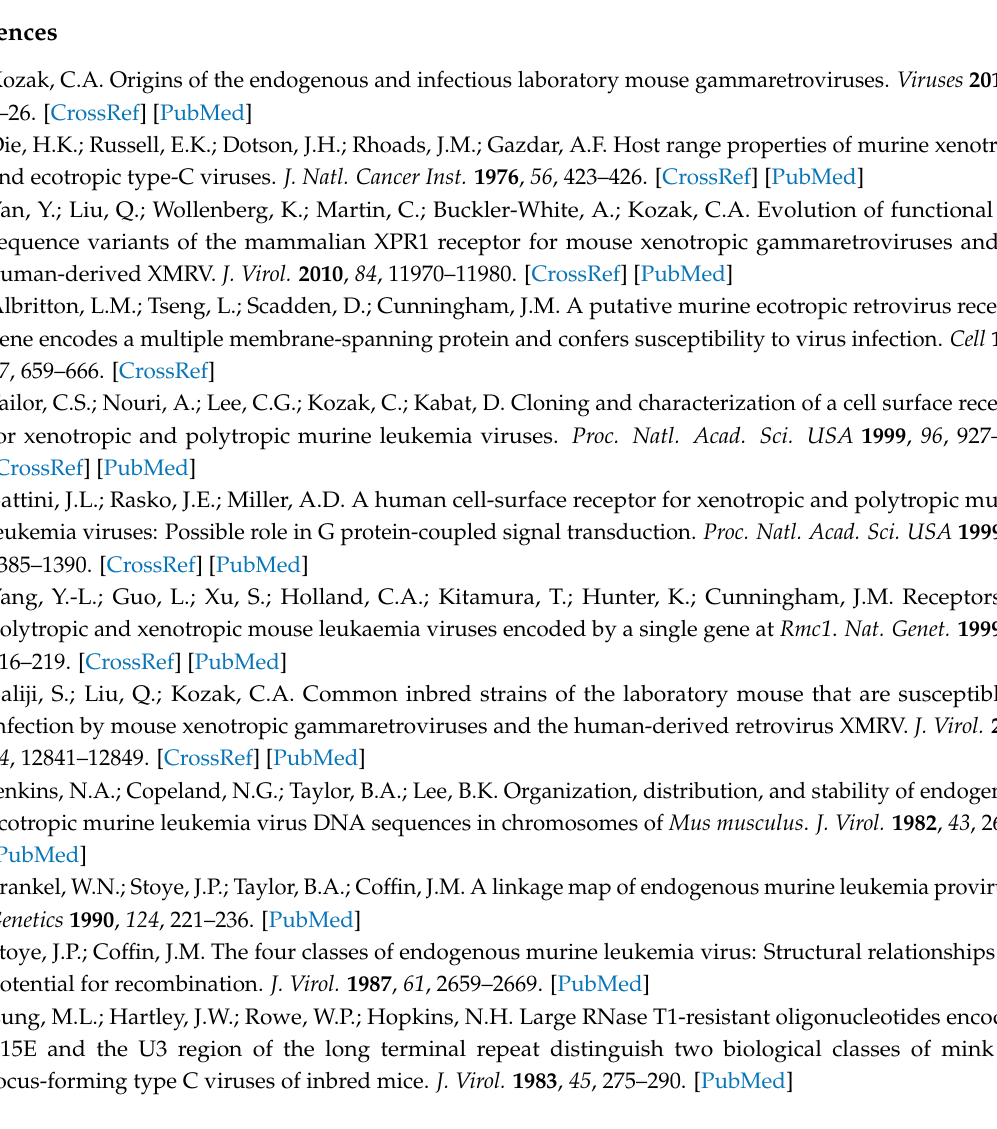
Table S1: Wild-derived or wild-caught M. musculus mice typed for Xmv67